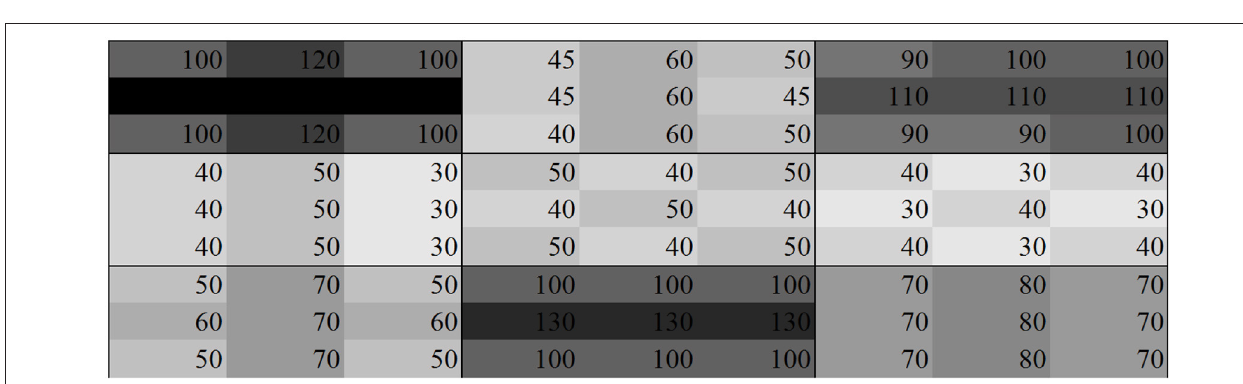
FIGURE 9 | Distribution of illuminance based on maximized coverage levels around the zones, with little emphasis on light installation cost, Point